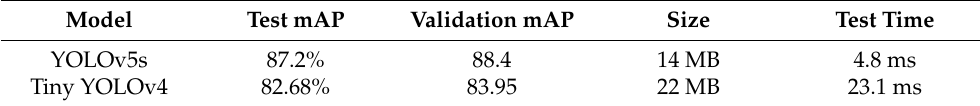
Table 4. Comparison between YOLOv5s and tiny YOLOv4.